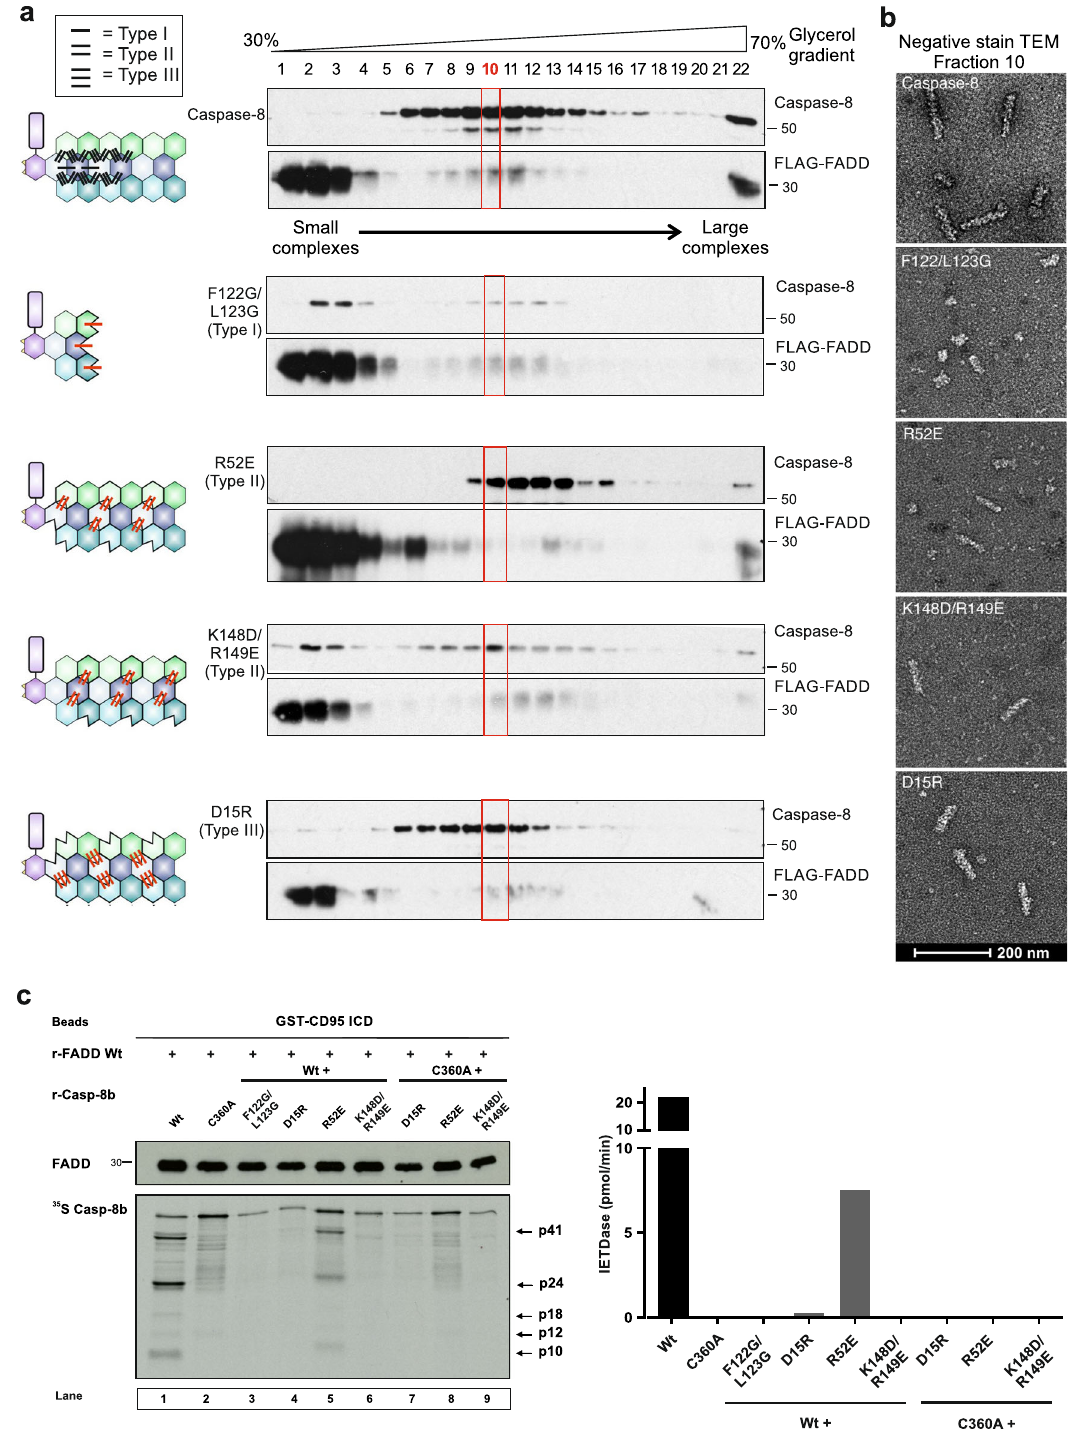
Fig. 4 tDED fi lament architecture is essential for Caspase-8 catalytic activity. a Left Panel, Schematics illustrate the position of Caspase-8 tDED Type I, II and III interaction mutants within triple helix fi lament. Right Panel, Western blot analysis of Glycerol Density Gradient pro fi les of full-length Caspase-8 C360A (Caspase-8) and full-length Caspase-8 tDED interaction mutants. Western blots are representative of 3 independent experiments. b Negative-stain EM of FADD in complex with full-length Caspase-8 C360A (Caspase-8) or Caspase-8 tDED interaction mutants. Representative fi laments visualized are from equivalent gradient fractions (Fraction 10), for each complex. Micrographs are representative of 3 independent experiments. c Reconstituted CD95 DISC (r-DISC; GST-CD95-IcD:r-FADD:r-Casp-8), assembled with Wt (Wild-type) or mutant 35 S r-Casp-8b. Beads were analyzed for r-Casp-8b cleavage and IETDase activity. Data shown are from one experiment, representative of 3 independent experiments. Source data are provided as a Source Data fi